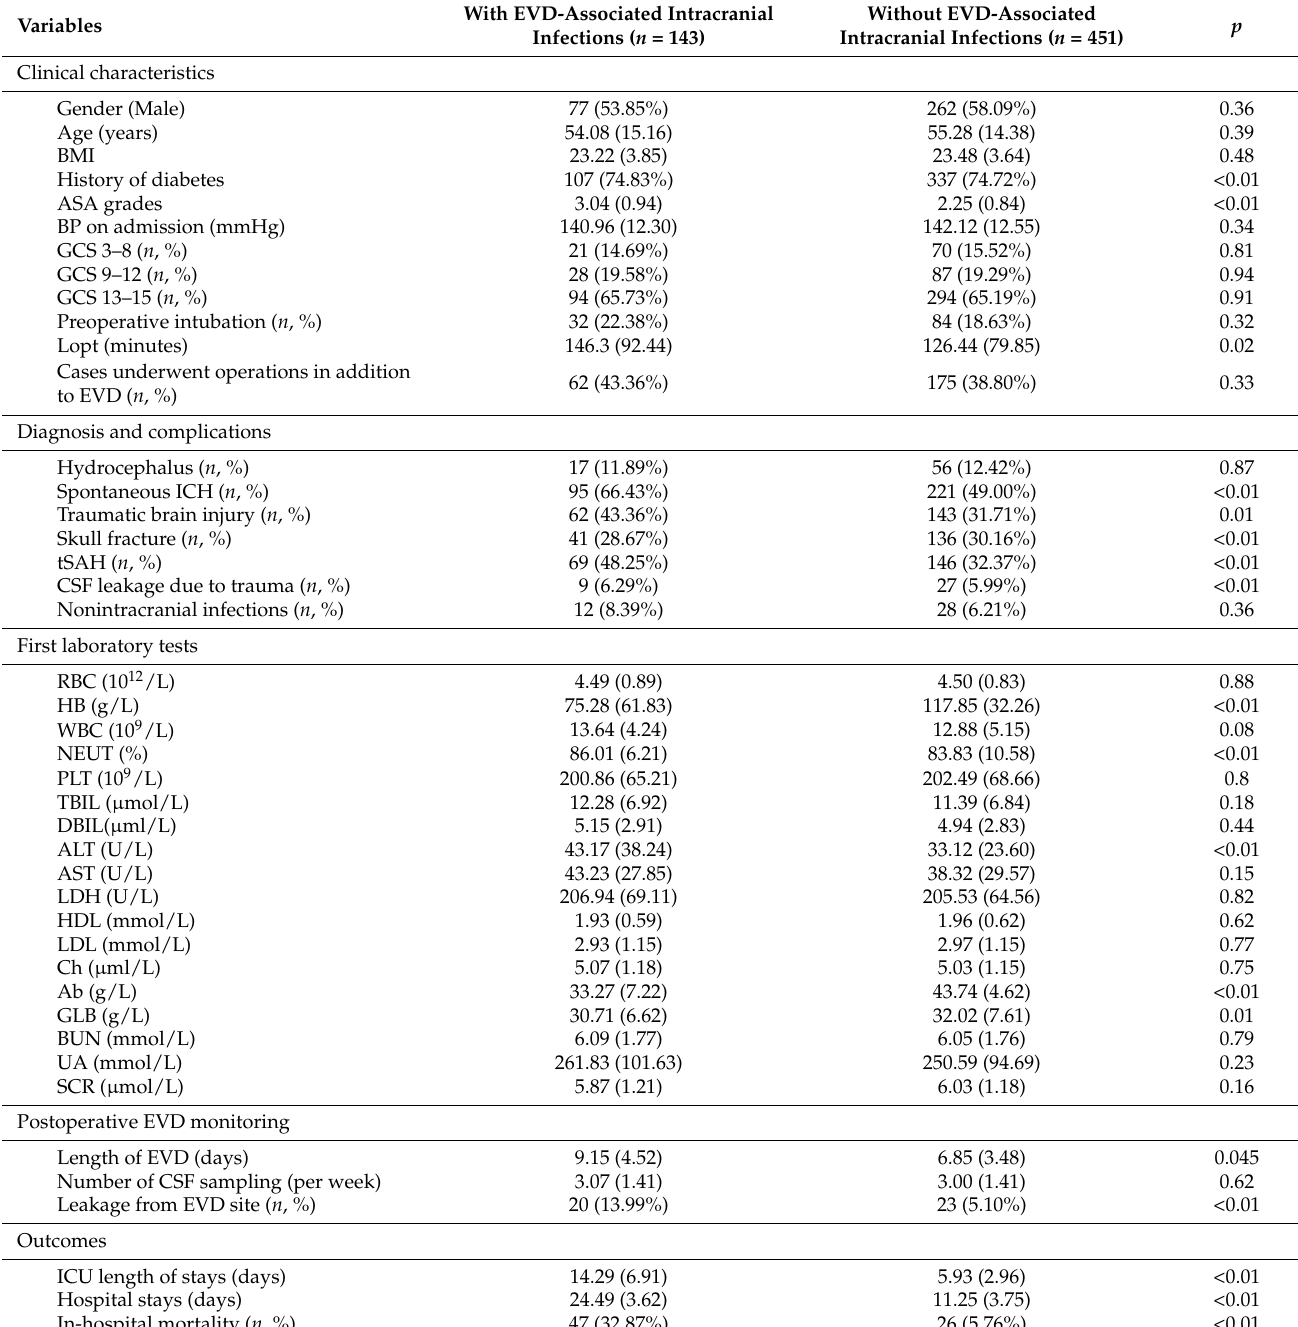
Table 1. Demographic and clinical features of recruited patients